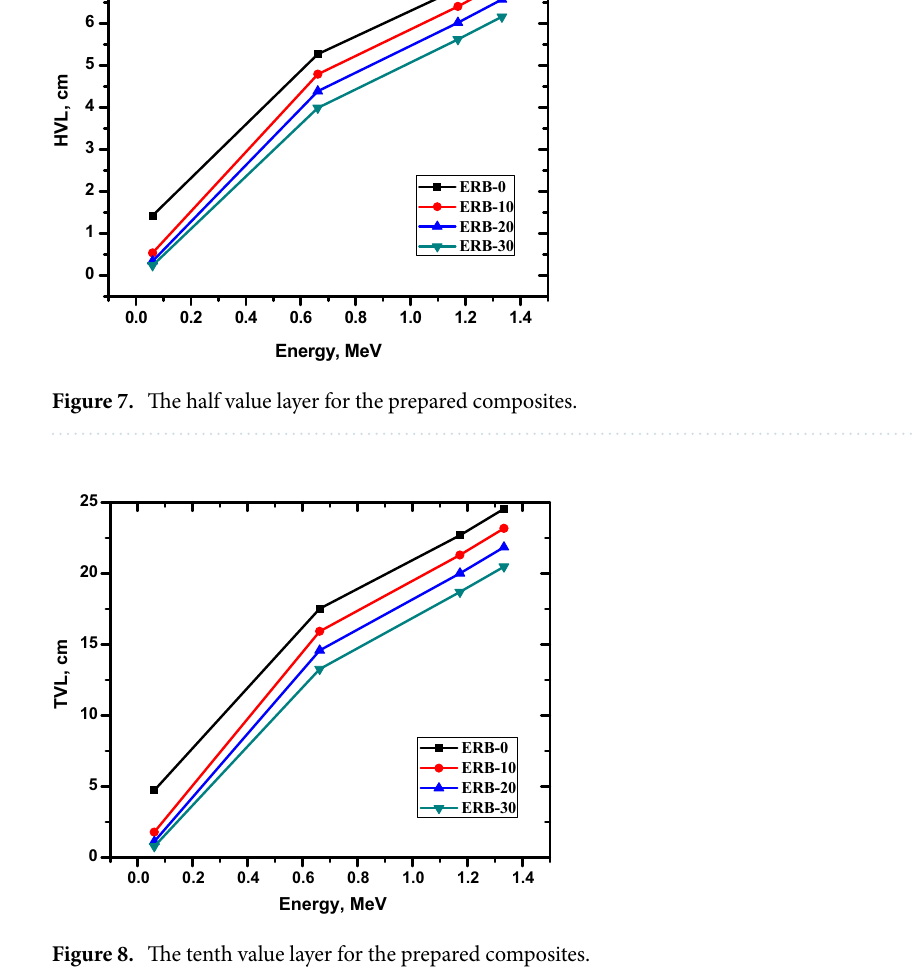
Figure 8. The tenth value layer for the prepared